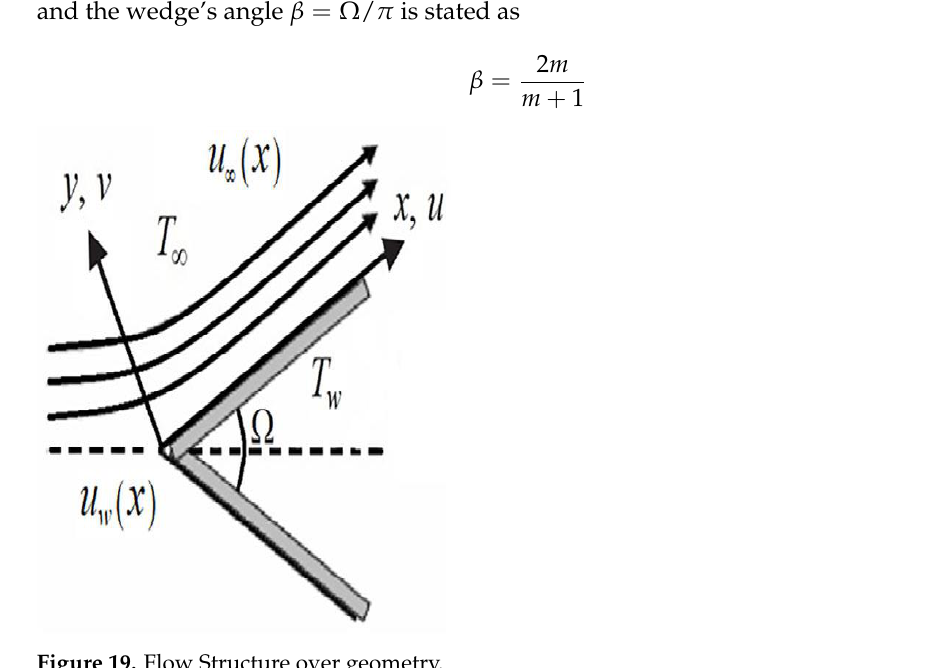
Figure 19. Flow Structure over geometry.